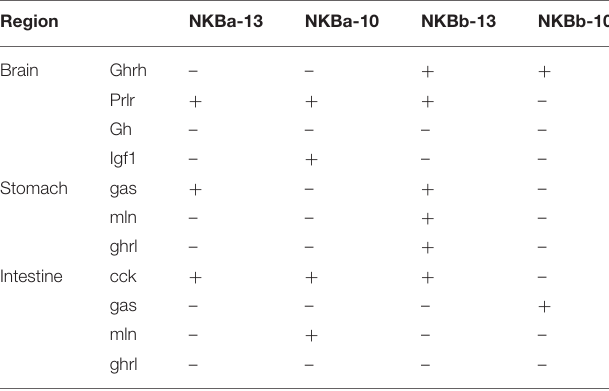
TABLE 2 | The effect of NKBs on the mRNA levels of growth-related genes and brain-gut peptide (BGP)-related genes in vitro . Region NKBa-13 NKBa-10 NKBb-13 NKBb-10